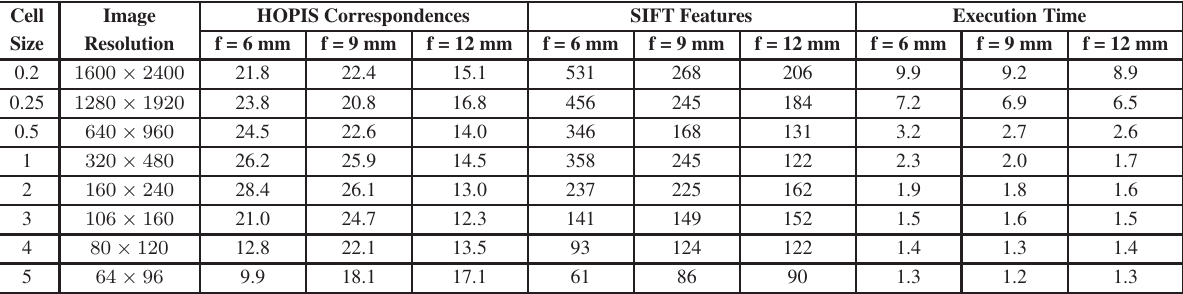
Table 2. SIFT feature detection and correspondence matching between the hybrid stereo image pairs for various focal lengths and image resolutions. The HOPIS correspondences are obtained from the average of ten image pairs. The SIFT features are those detected in the virtual images. The execution time is in